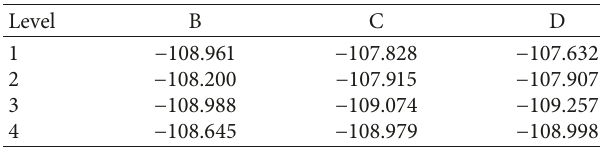
Table 9: SNR of maximum thinning rate of factors B, C, and